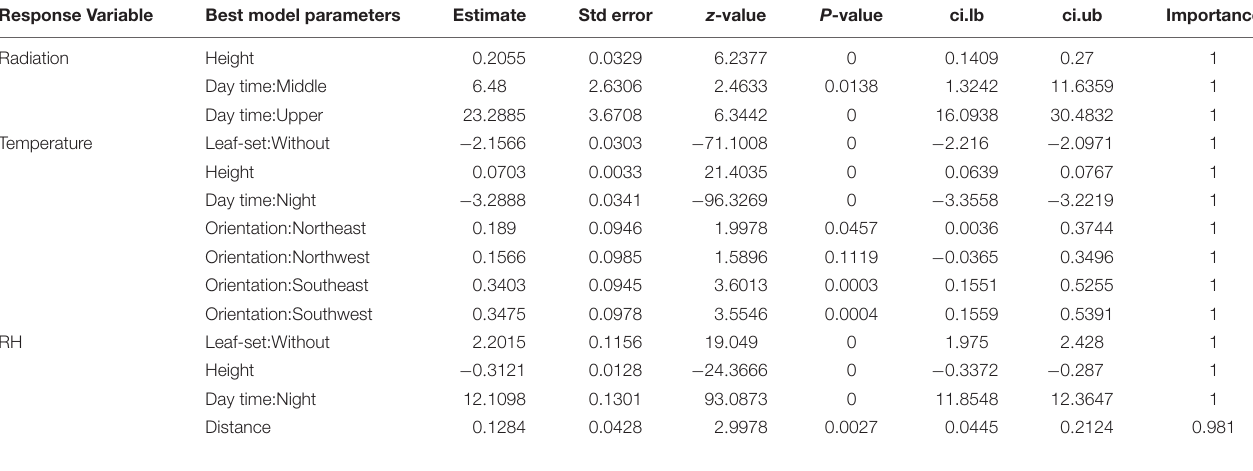
TABLE 1 | Summary of multi-model inference results, testing the effect of tree height, horizontal distance to the tree center, cardinal orientation, day- and night-time, and leaf-set on radiation, temperature, and RH. Response